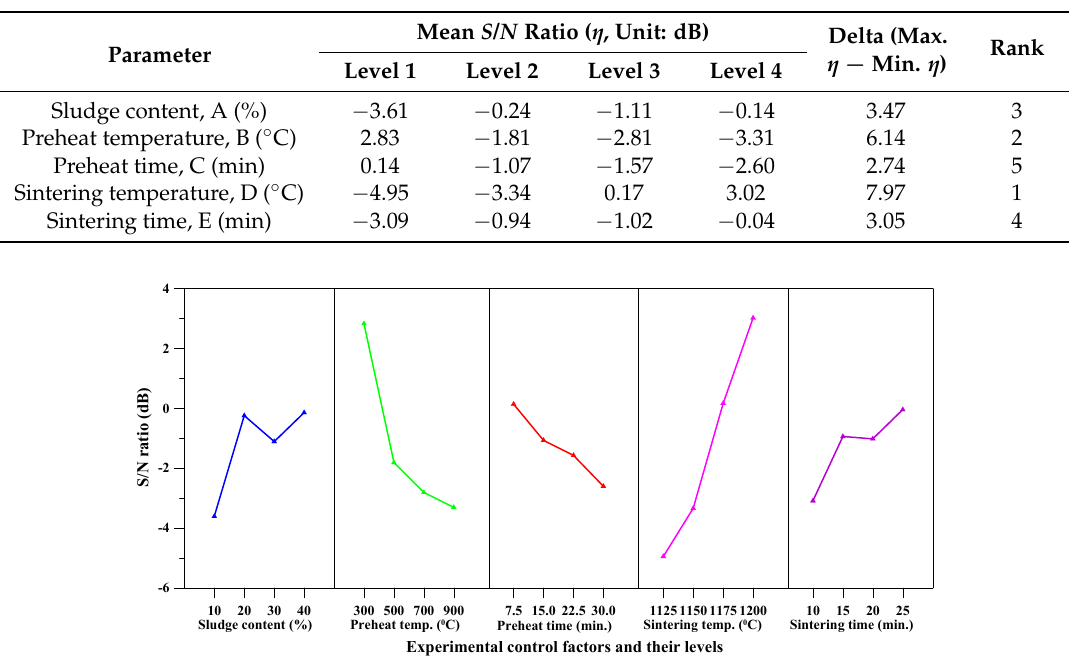
Table 6. S / N response table for particle density.